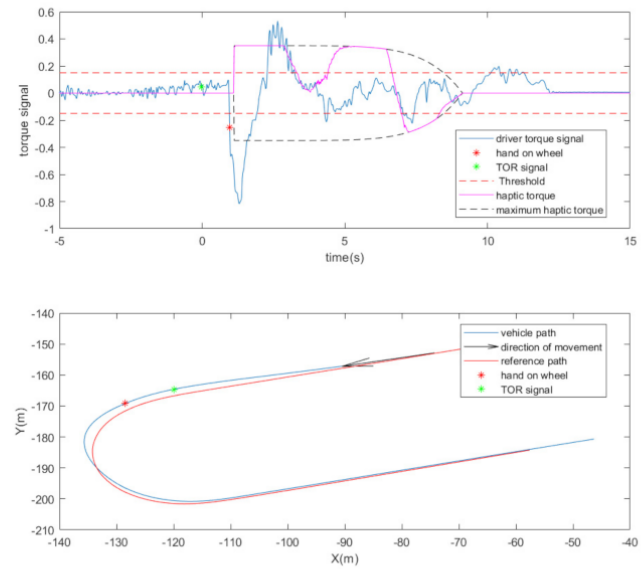
Figure 7. Top plot presents the driver’s torque and the haptic torque for 1 instance. Bottom plot presents the corresponding vehicle movement in the